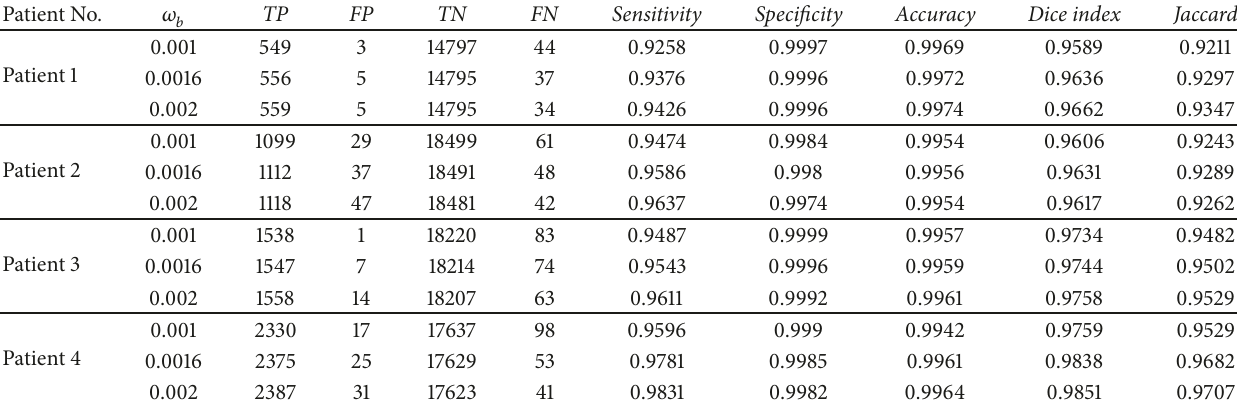
Table 3: The calculated segmentation evaluation metrics for the proposed approach by considering different values of blood perfusion rate. Patient No.